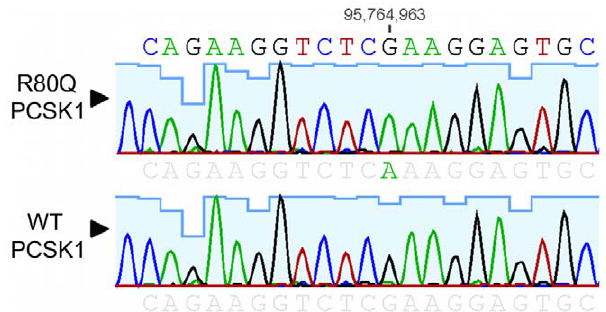
Figure 2. Direct Sanger sequencing of genomic DNA from a subject bearing the Arg80Gln